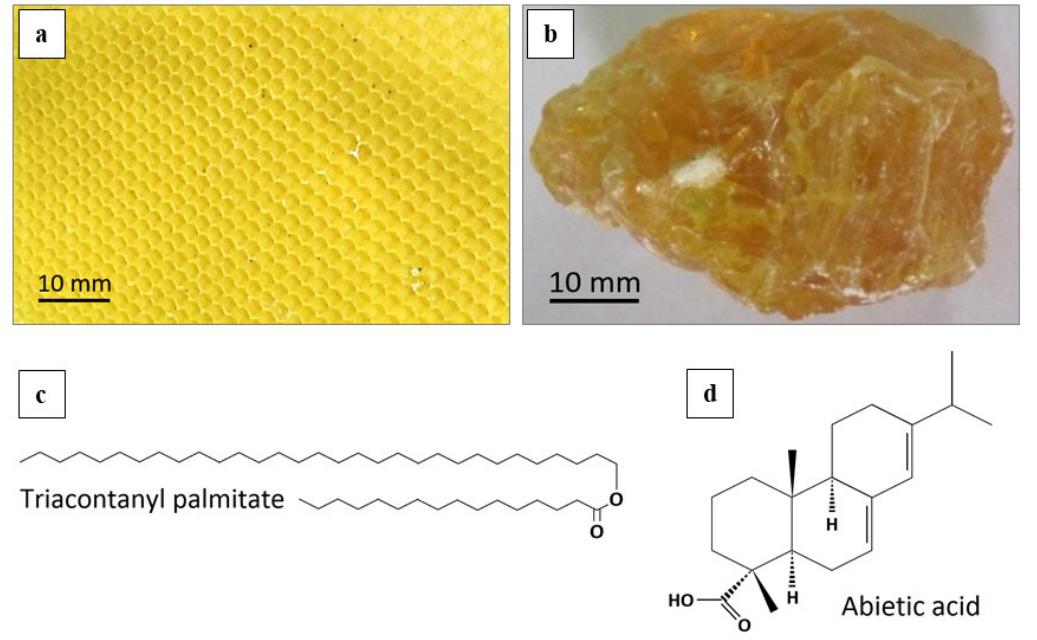
Figure 1. Images showing ( a ) natural beeswax; ( b ) colophony; ( c ) molecular structure of triacontanyl palmitate as the major component of beeswax; and ( d ) molecular structure of abietic acid as the major component of